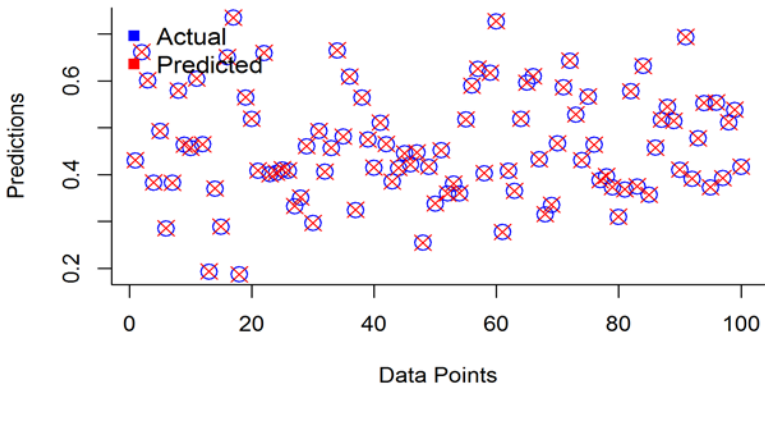
Fig. 8. The prediction results for (a) IT2FLS.